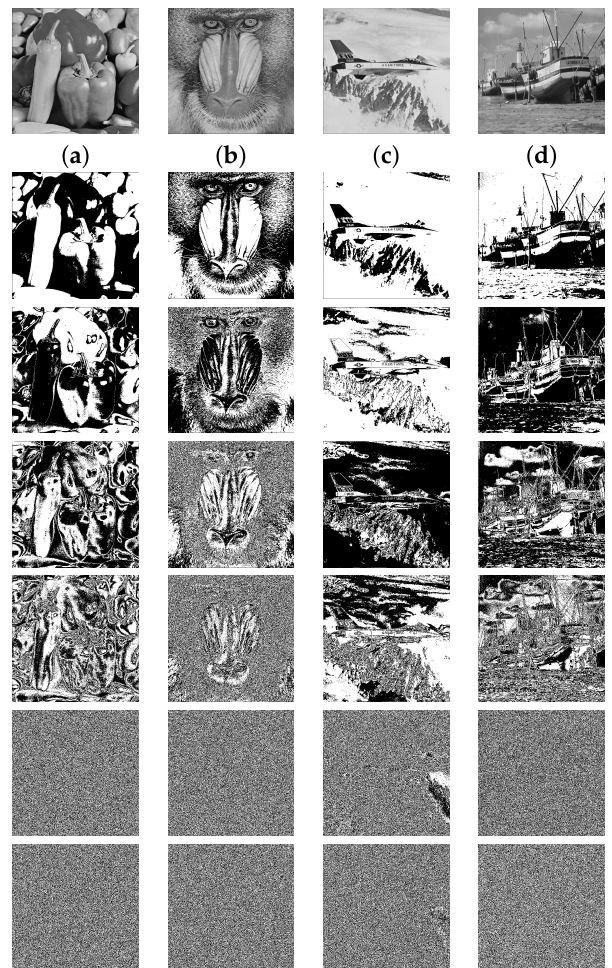
Figure 6. Bit planes extracted from the natural images (Row 1: original images. ( a ) Peppers, ( b ) baboon, ( c ) airplane, ( d ) boat. Row 2: plane 7; row 3: plane 6; row 4: plane 5; row 5: plane 4; row 6: plane 1; row 7: plane